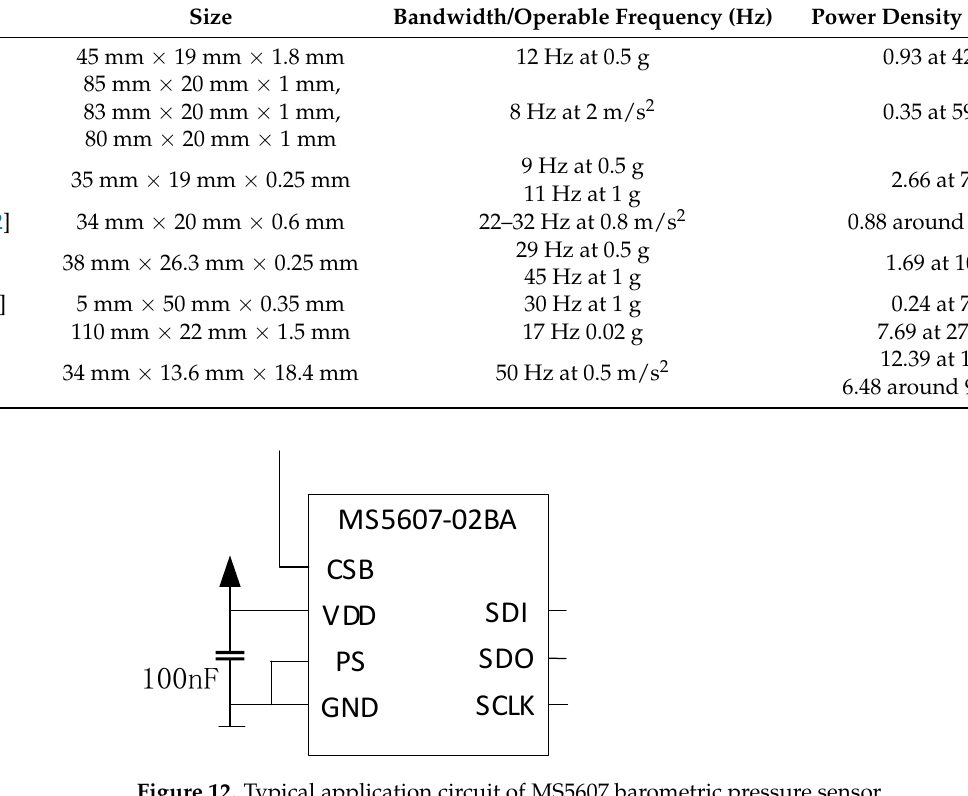
Table 5. Comparison of the contemporary VEH devices with this work.